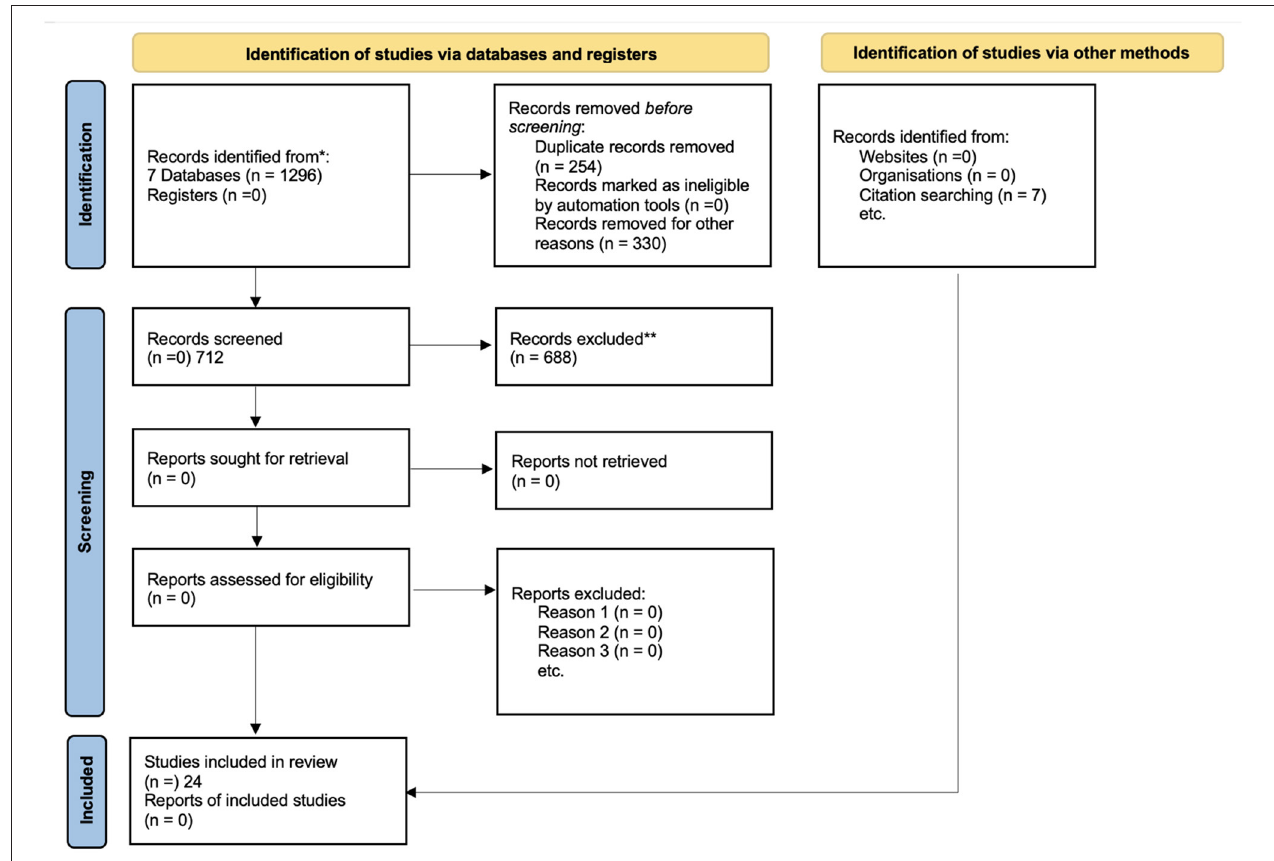
FIGURE 1 | PRISMA flow chart of the search and selection